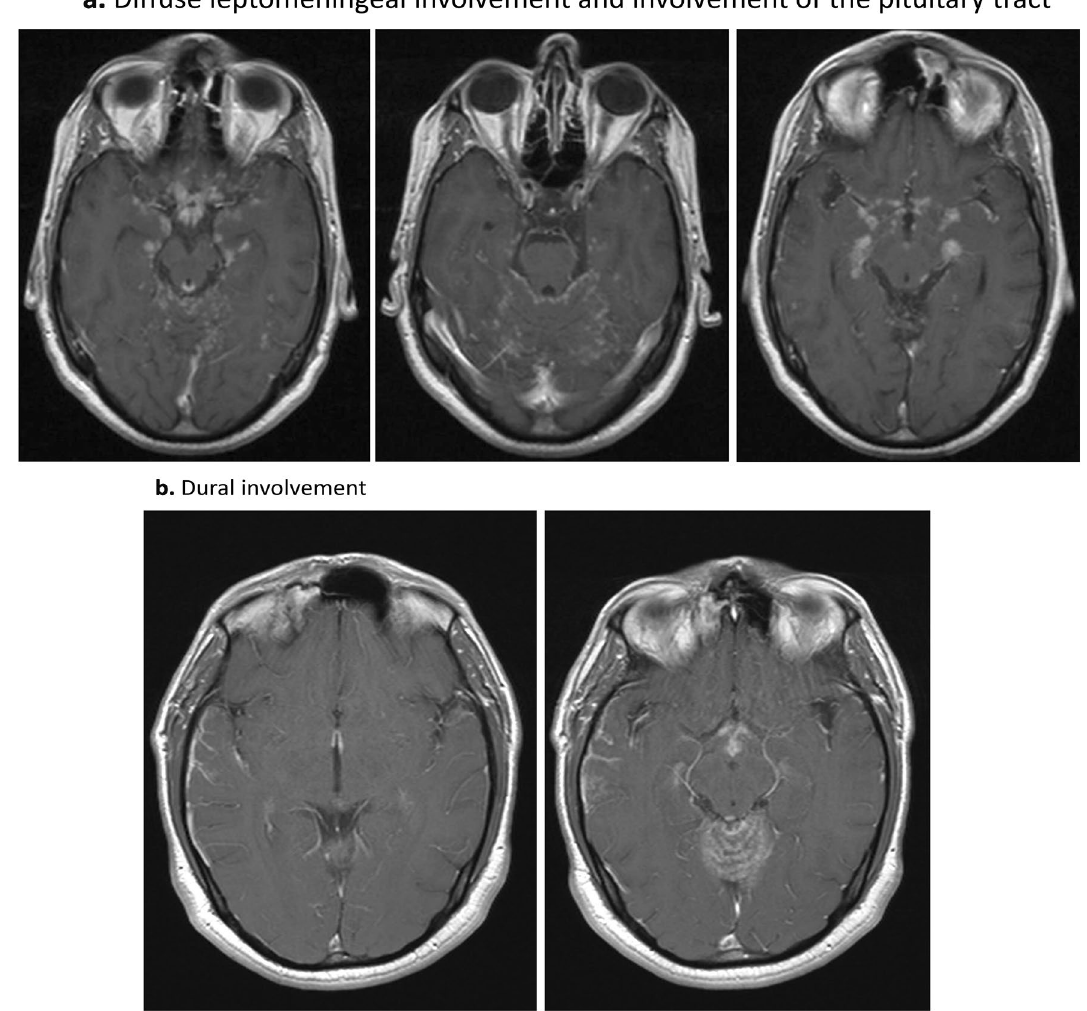
Figure 2. Leptomeningeal and dural involvement. ( a ) Diffuse leptomeningeal involvement and involvement of the pituitary tract; ( b ) Dural and IVIG in 1. Data from therapeutic response was available in 11 cases and included a complete response in 5 (45.5%), partial improvement in 1 (9%) and no response in 5 (45.5%). Comparison studies. Differences according to anatomical involvement. No significant differences were found between patients with CNS involvement and those with PNS involvement except for a trend for a higher frequency of women in patients with CNS involvement and a higher frequency of renal involvement in those with PNS involvement (14% vs 0%, p = 0.025) (Table 3). In patients with CNS involvement, no significant dif- ferences were found between those with brain involvement and those with CNS involvement out of the brain except for a higher frequency of multiple anatomical involvements in patients with brain involvement (38% vs 3%, p < 0.001) (Sup. Table 2). Patients presenting with a unique CNS neurological involvement showed a higher frequency of raised ECA levels (62% vs 29%, p = 0.036) and a lower frequency of salivary gland involvement (10% vs 31%, p = 0.044) in comparison with those with multiple CNS sites involved (Sup. Table 3). Comparison with patients without neurosarcoidosis. Patients with CNS neurosarcoidosis presented a higher frequency of radiological Scadding Stage 0 (18% vs 7%, q = 0.018), a higher frequency of ocular (27% vs 10%, q < 0.001) and salivary gland (15% vs 4%, q = 0.002) WASOG involvements, and a higher frequency of use of corticosteroids (96% vs 47%, q < 0.001) and immunosuppressive/biological agents (35% vs 8%, q < 0.001) in comparison with patients without neurosarcoidosis, while those with PNS neurosarcoidosis showed a higher frequency of liver involvement (36% vs 12%, p = 0.02) and a trend for a higher frequency of spleen involvement (21% vs 7%, p = 0.08) that were not statistically significant in the corrected statistical analysis (Table 3).